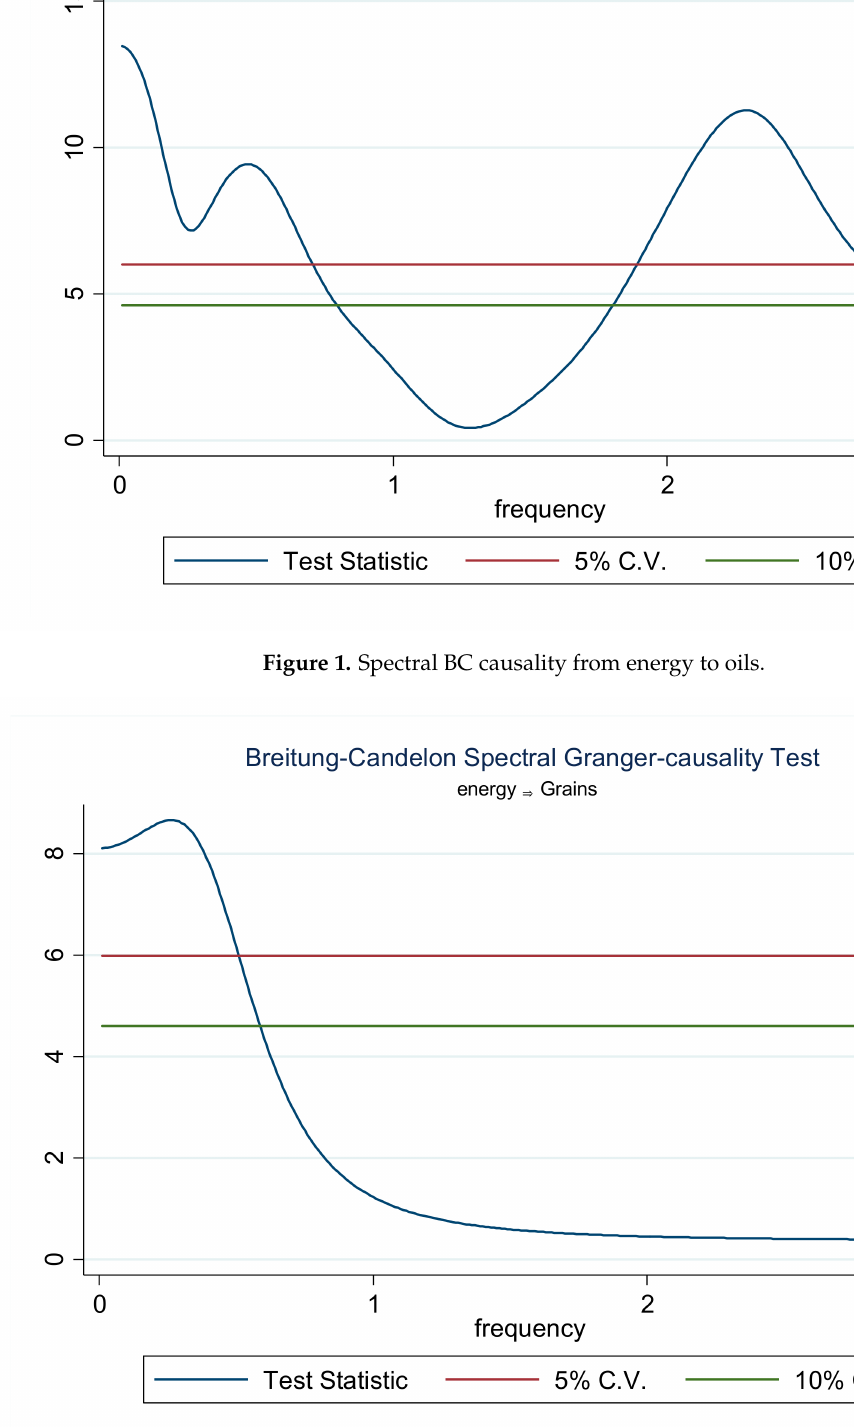
Figure 2. Spectral BC causality from energy to